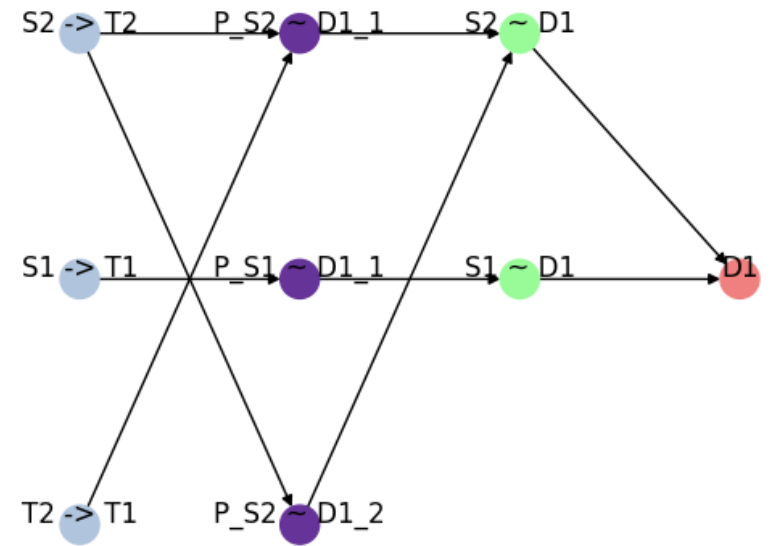
Figure 1. Single demand Bayesian Model